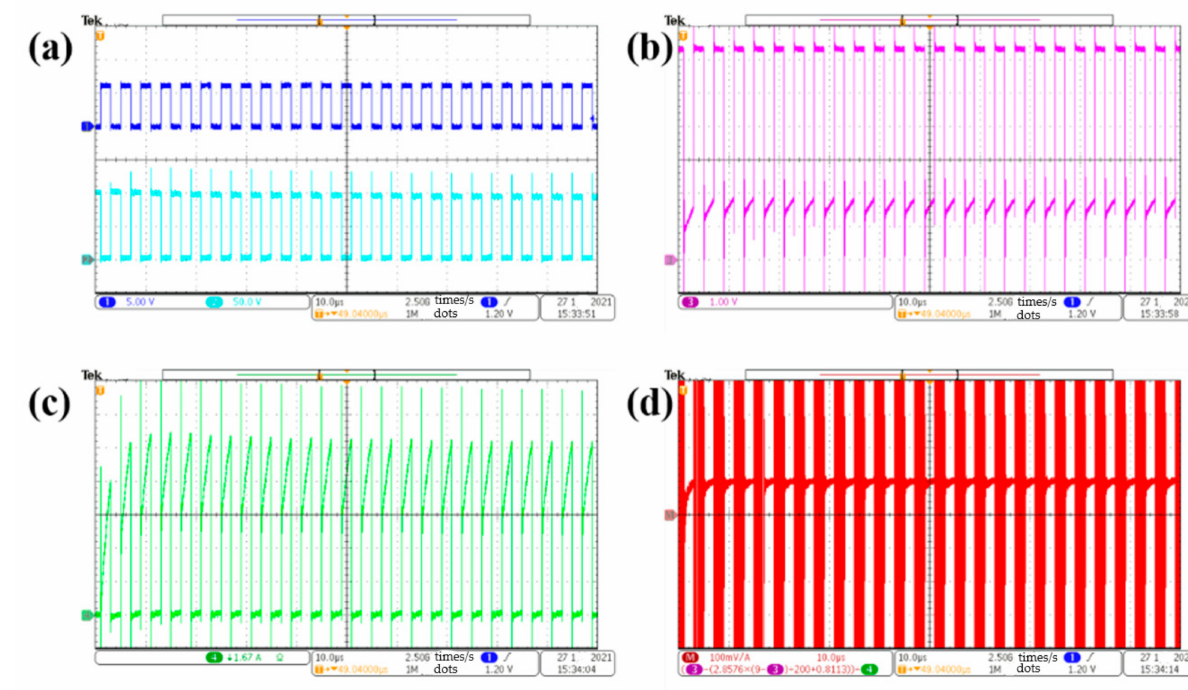
Figure 6. The real waveform of a multi-pulse test at 100 V and 250 kHz: ( a ) V GS and V DS ; ( b ) V DS(m) ; ( c ) I DS ; ( d ) dynamic R ON